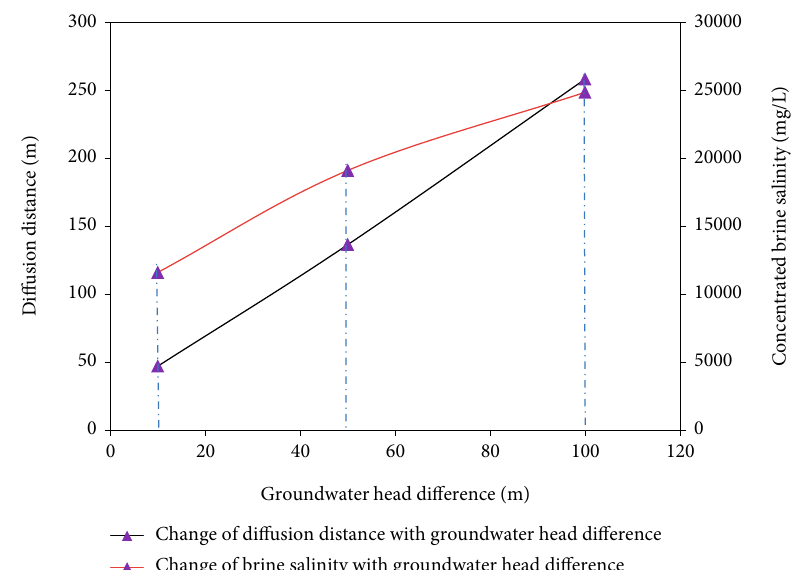
Figure 10: Relationship curve between the di ff usion distance of concentrated brine, the ground-water head di ff erence, and the salinity at the outer wall of the underground storage after 50 years of long-term penetration. Table 7: Increase in simulated data for 70 years of long-term penetration compared to 50 years of long-term penetration. Groundwater head di ff